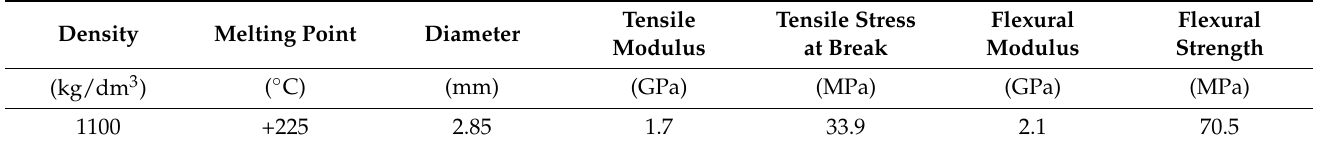
Table 3. Key properties of the acrylonitrile–co-butadiene–co-styrene (ABS)